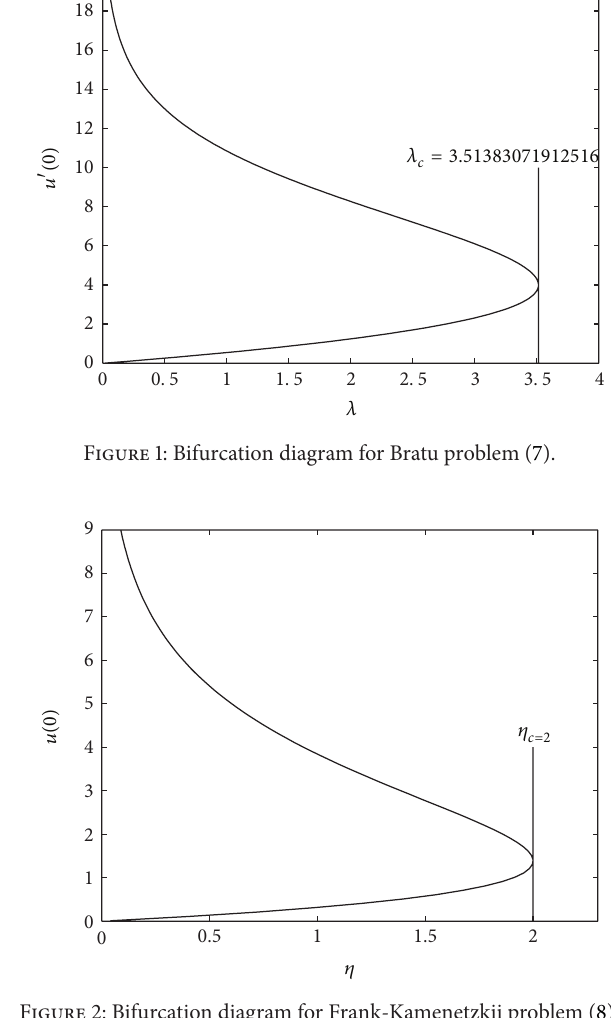
error for Bratu problem is (Scheme-0, 𝑁 = 50 , 6.66 e − 49), (Scheme-2, 𝑁 = 100 , 6.34 e − 49), (Scheme-2, 𝑁 = 150 , 6.34 e − 49), and (Scheme-3, 𝑁 = 200 , 6.34 e − 49) in Table